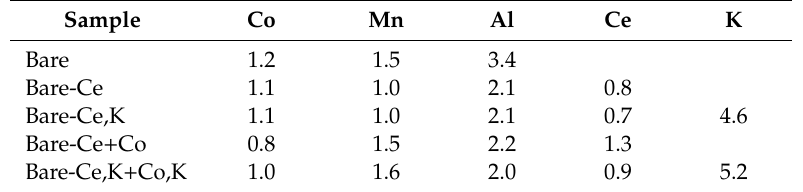
Table 6. Ratio of surface and bulk concentrations (given in wt.%) of Co, Mn, Al, Ce, and K. Sample Co Mn Al Ce K Bare 1.2 1.5 3.4 Bare-Ce 1.1 1.0 0.8